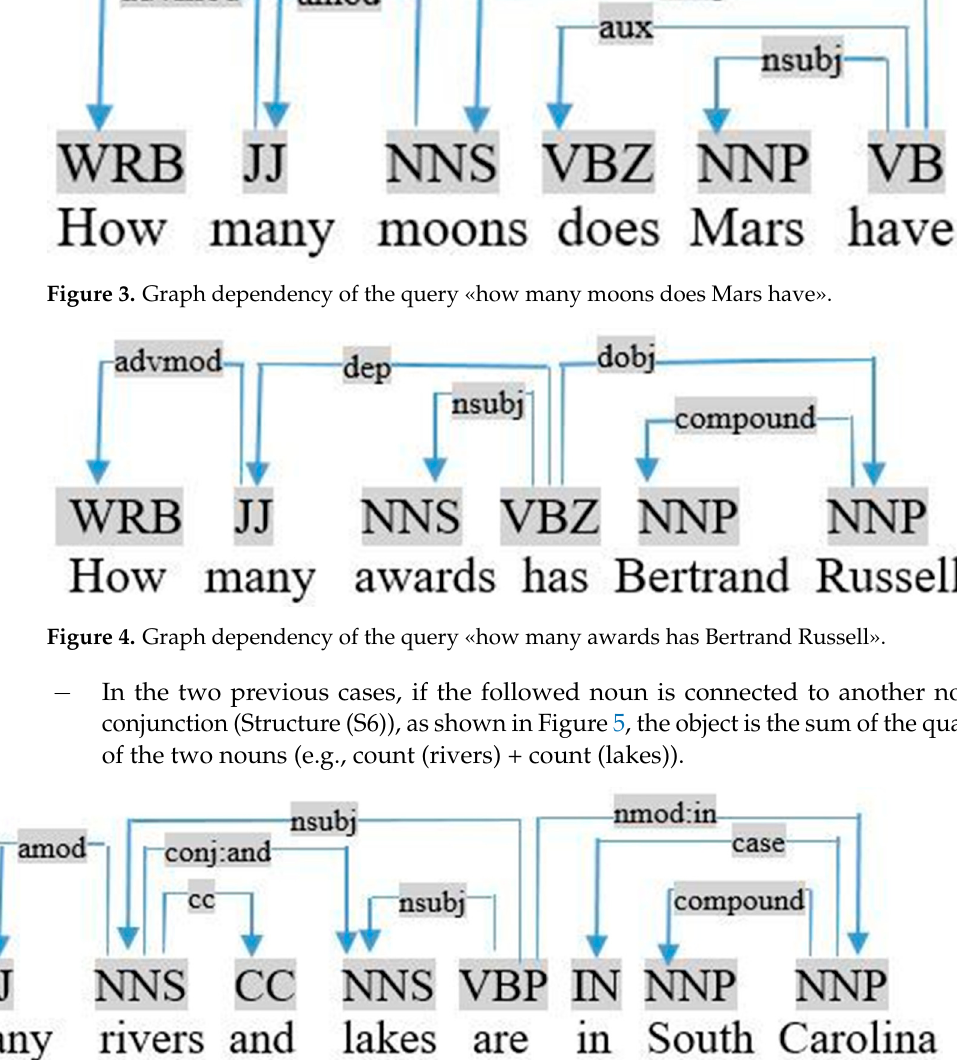
Figure 5. Graph dependency of the query «how many rivers and lakes are in South Carolina». 4